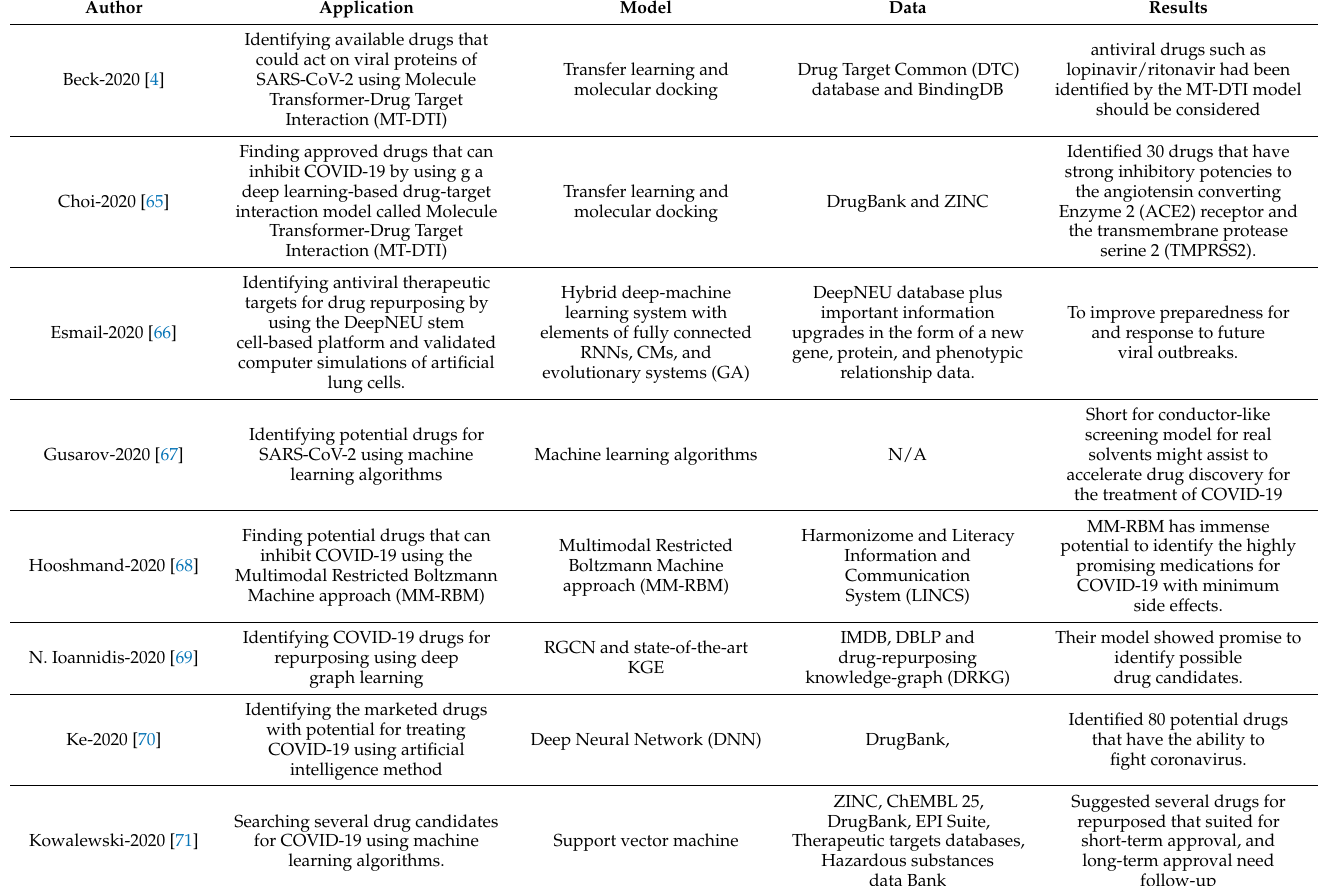
Table 4. Application of AI for COVID-19 drug